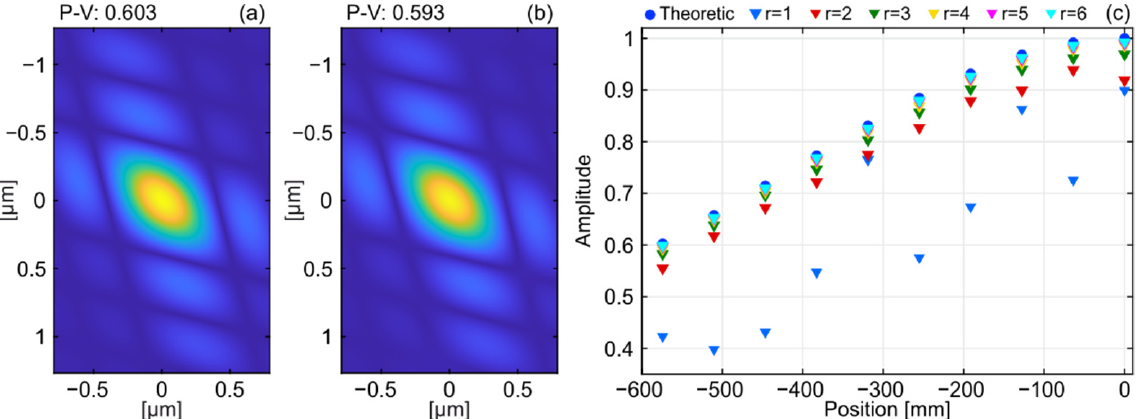
Figure 5. Evaluation of off-axis single point reconstructions with the OADI method; ( a ) Reconstructed amplitude of the point source P 10 from theoretical CGH; ( b ) Reconstructed amplitude of the point source P 10 from PAS CGH; and ( c ) normalized reconstructed amplitudes for several N so and r.